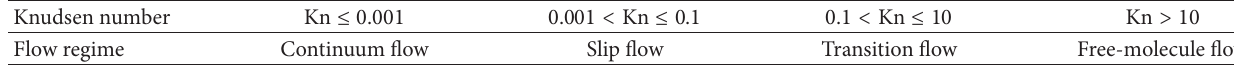
Table 1: Classification of gas flow regimes based on Knudsen number.